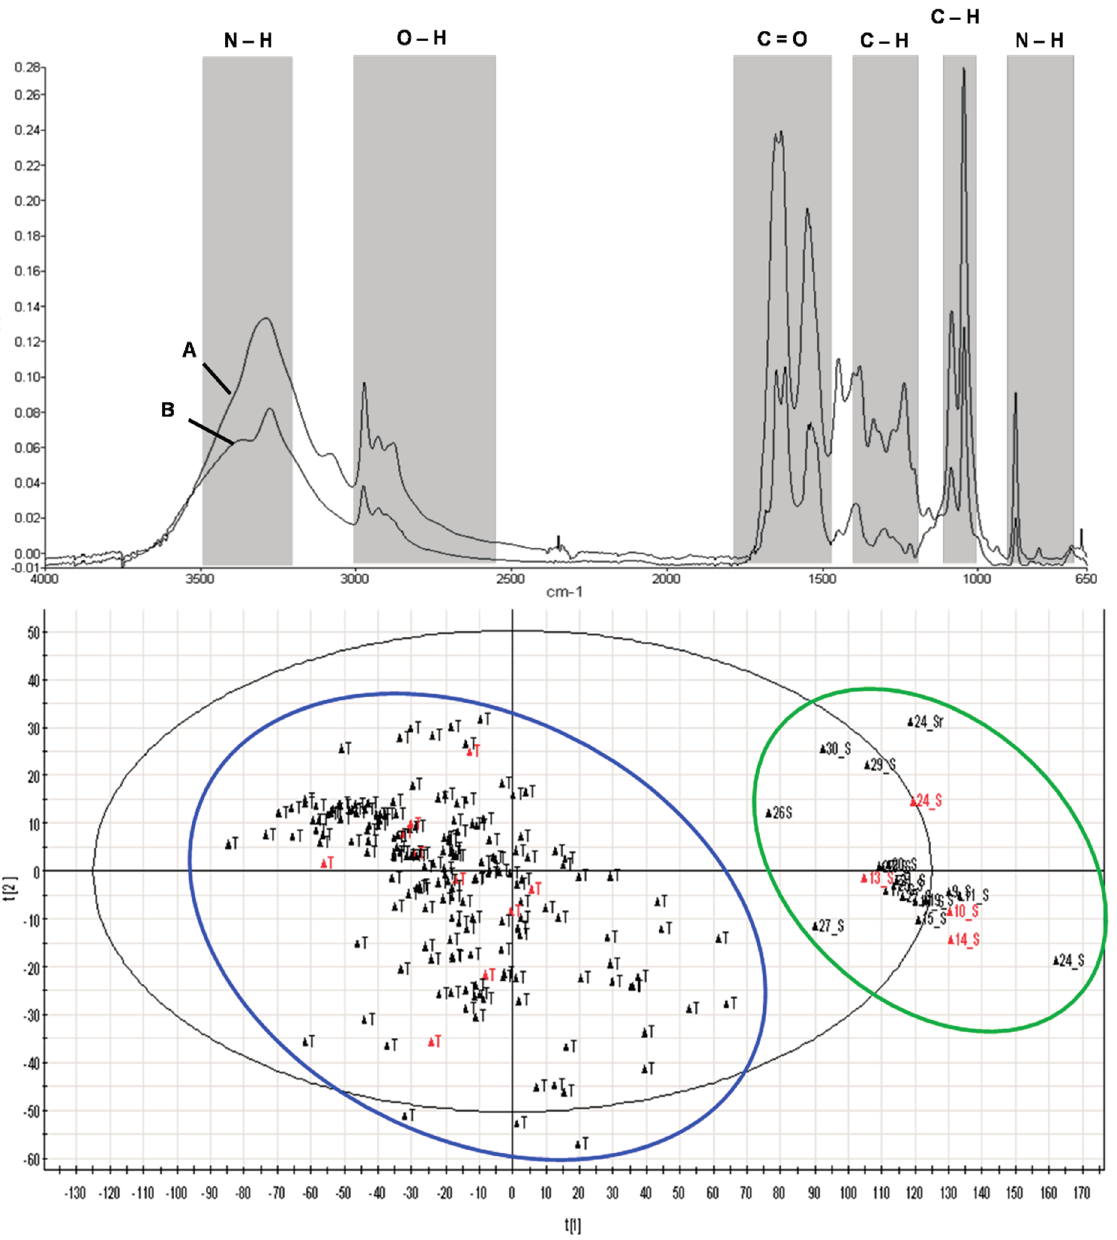
Figure 3. Two-dimensional plot using the first two principal components. Green cluster represents location from Sabah (A) and blue cluster represents location fromTerengganu (B). Red plot represents E. hexagonatus and black plot represents E. fuscoguttatus